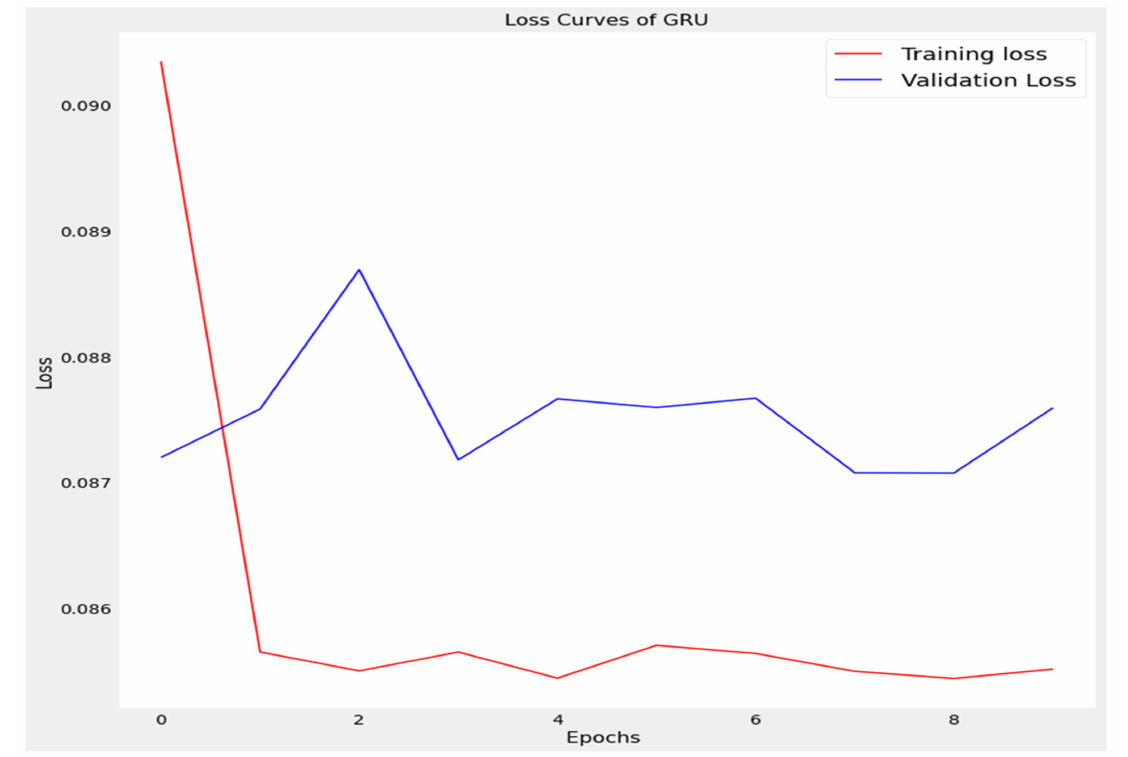
Figure 8. Loss curve of gated recurrent unit (GRU).